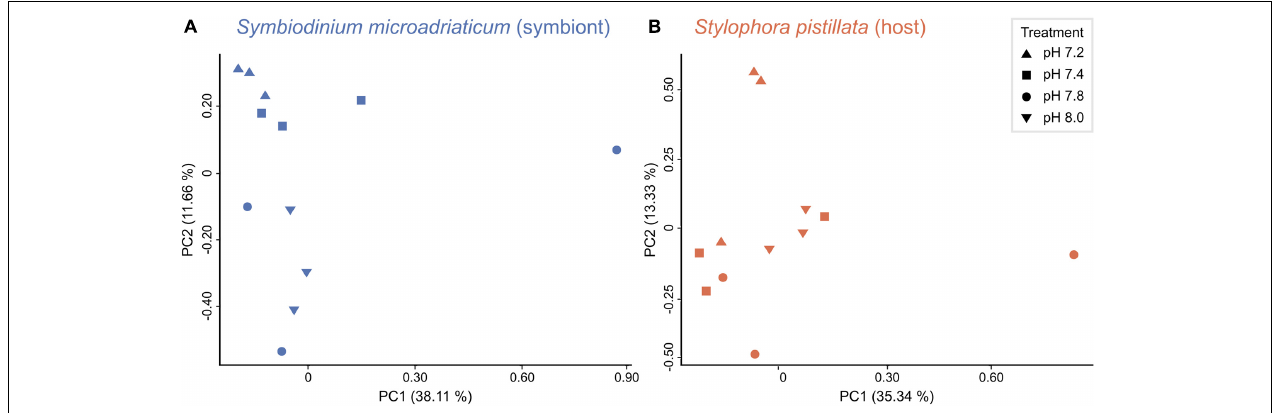
FIGURE 2 | Relationship between samples. Principal component analysis (PCA) of (A) in hospite Symbiodinium microadriaticum CCMP2467 and (B) Stylophora pistillata samples across all four treatments.